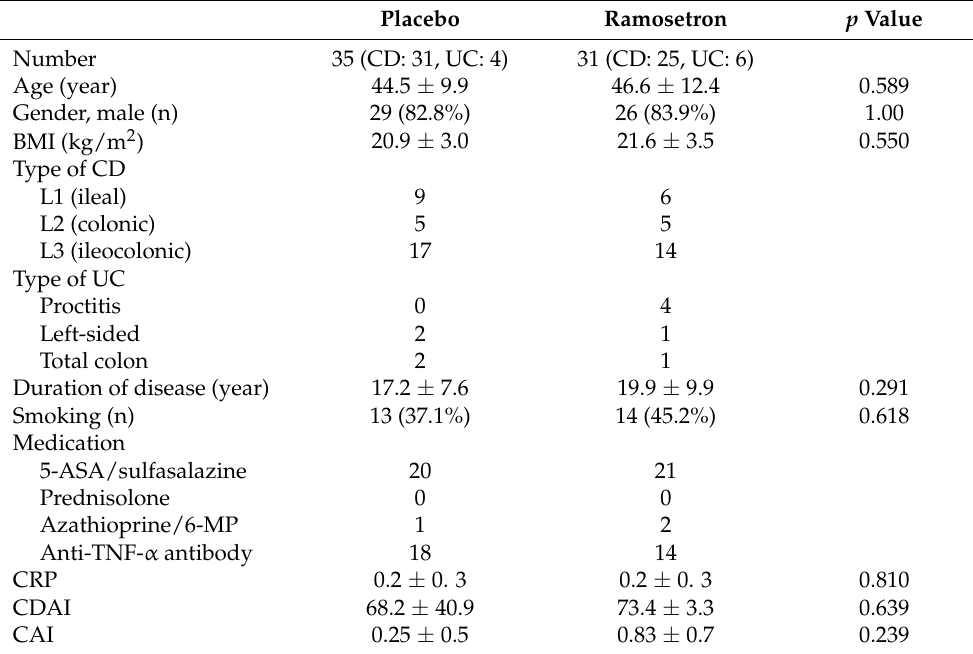
Table 1. Demographics and baseline